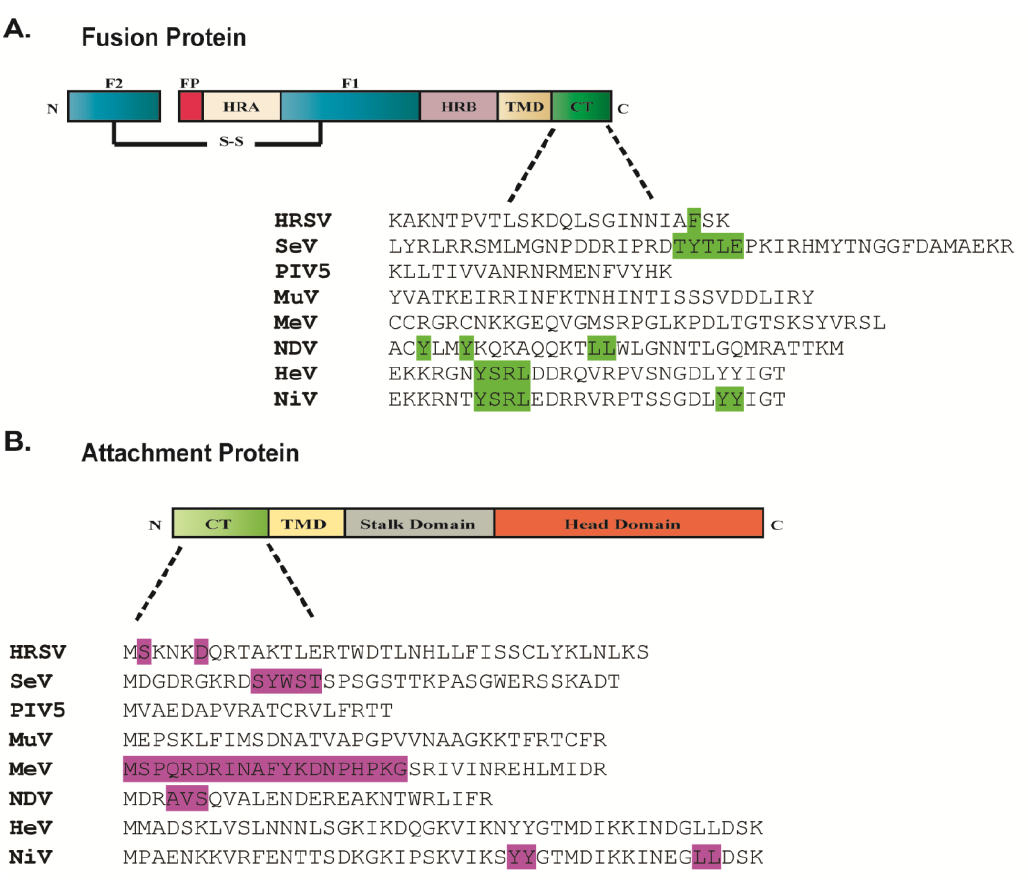
Figure 3. Amino acid sequences of the cytoplasmic tails of the fusion protein ( A ) and attachment protein ( B ) of different paramyxoviruses. Amino acid residues highlighted contribute to paramyxovirus particle production. Sequences of cytoplasmic tails were obtained from